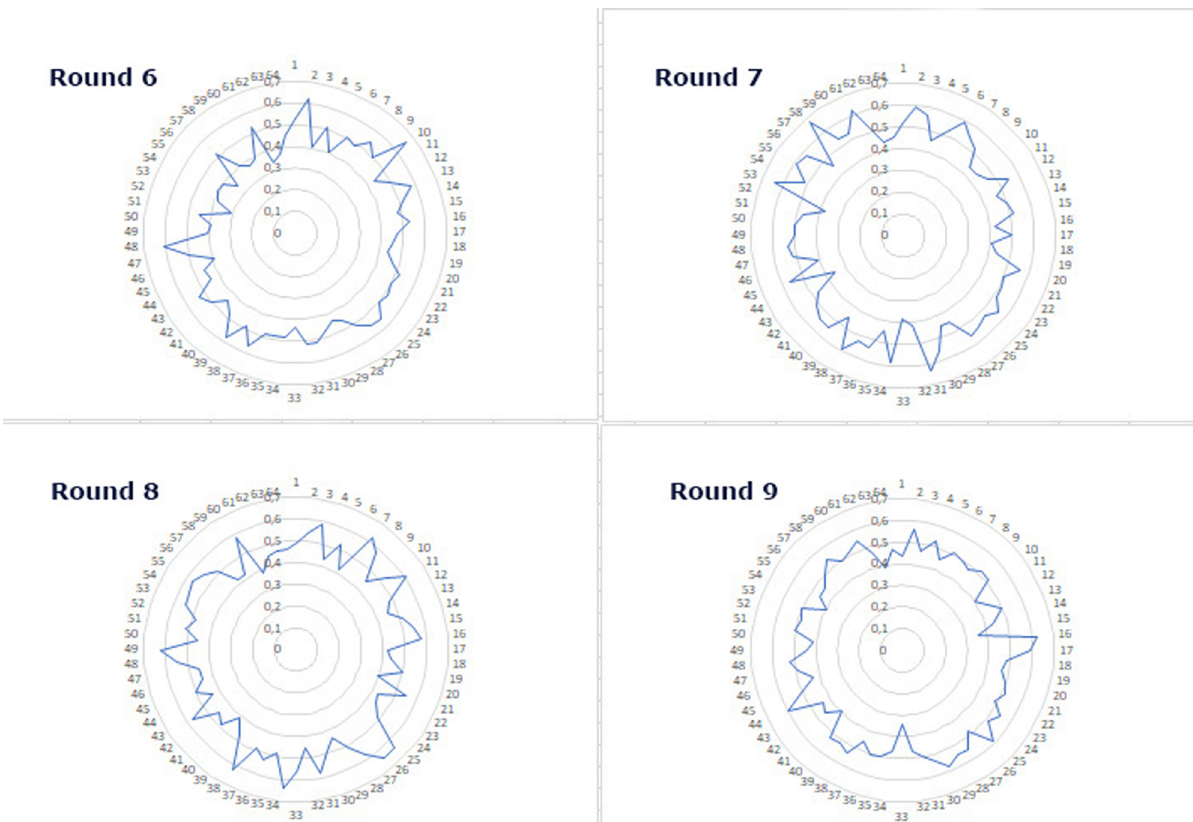
Figure 3: Histogram of avalanche parameter values in rounds 6 – 9.